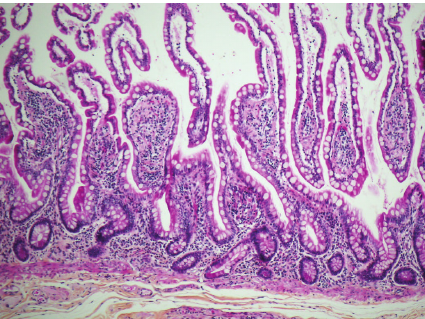
Figure 2: Normal ileal mucosa 4 months following cessation of olmesartan (HPS,